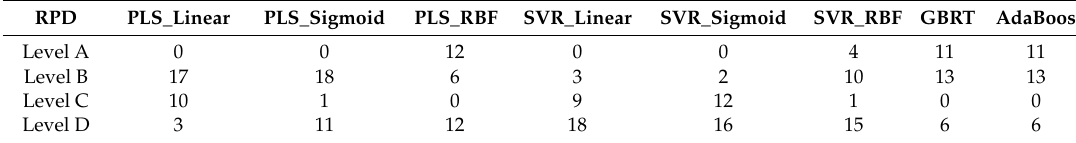
Table 5. The number of di ff erent models at varying RDP